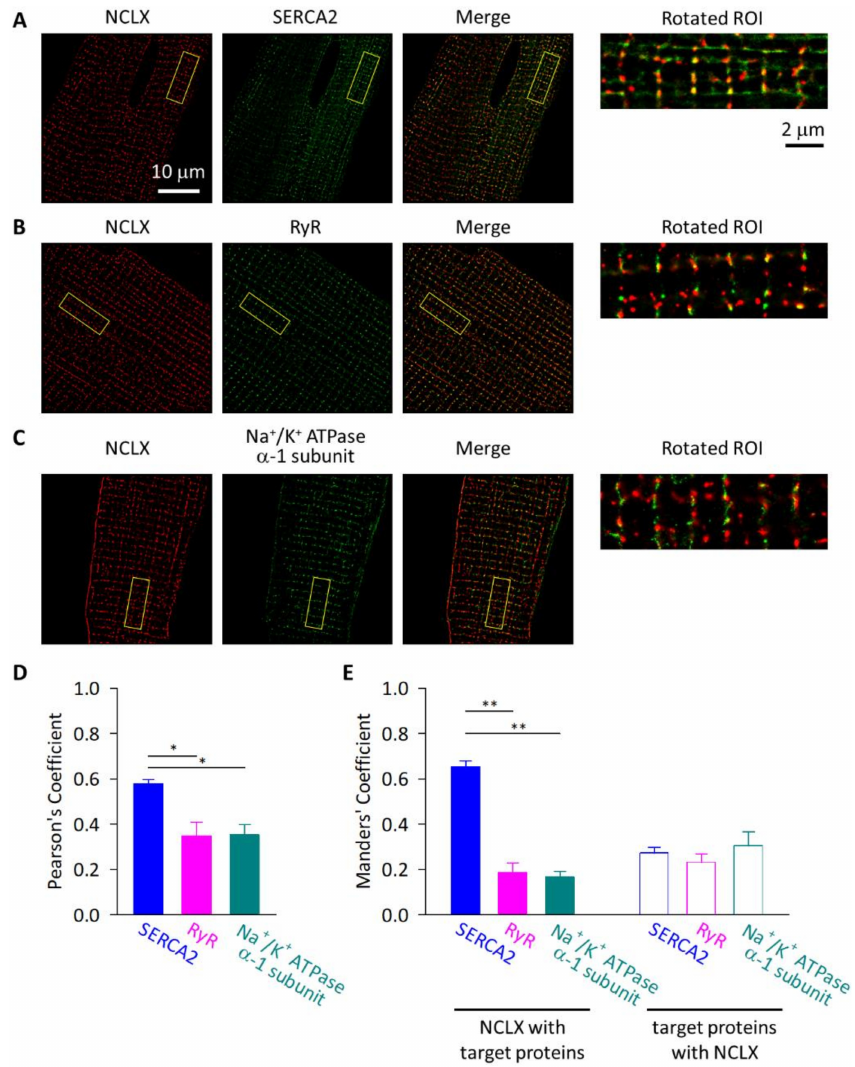
Figure 6. Super-resolution imaging of mouse ventricular myocytes. Isolated cells were co- immunostained with anti-NCLX antibody and anti-SERCA2 ( A ), anti-RyR ( B ), and anti-Na + /K + ATPase α -1 subunit ( C ) antibodies, then images were obtained using an N-STORM (Nikon). NCLX- derived CF568 signals and SERCA2-, RyR-, and Na + /K + ATPase α -1 subunit-derived Alexa Fluor 647 signals are shown as red and as green, respectively. The merged images are also shown. The ROIs for six sarcomeres-containing regions highlighted as yellow squares were rotated so that the longitudinal axis of the sarcolemma in the cardiomyocytes in each image became parallel to the x axis of the image (magnified images in the rightmost panels). ( D ) Pearson’s correlation coefficients for co-localization of NCLX and target proteins, SERCA2, RyR, and Na + /K + ATPase α -1 subunit. ( E ) Manders’ co-localization coefficients for NCLX and target proteins. Fractions of NCLX co-localized with target proteins and those of target proteins co-localized with NCLX are shown as closed and open columns, respectively. Data are expressed as mean ± s.e.m. of 4–6 cells. * p < 0.05; ** p <